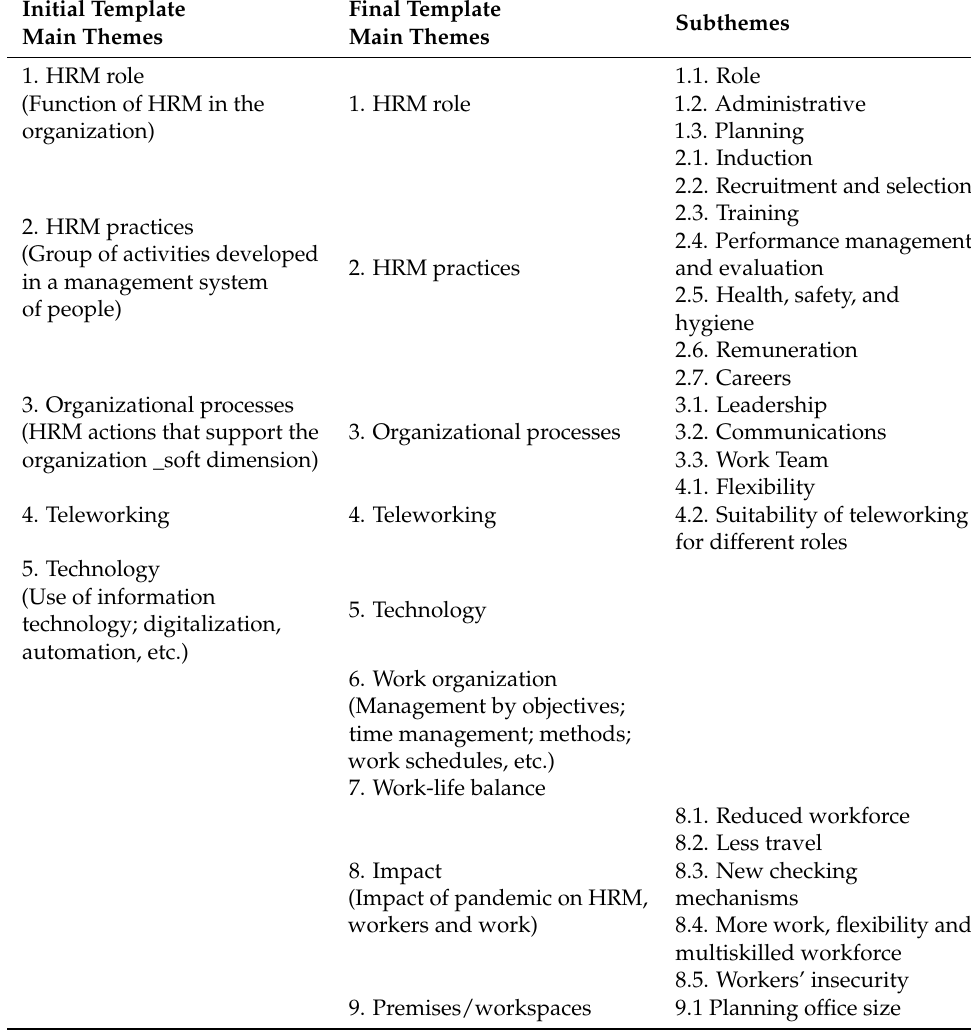
Table 3. Coding template for human resource managers’